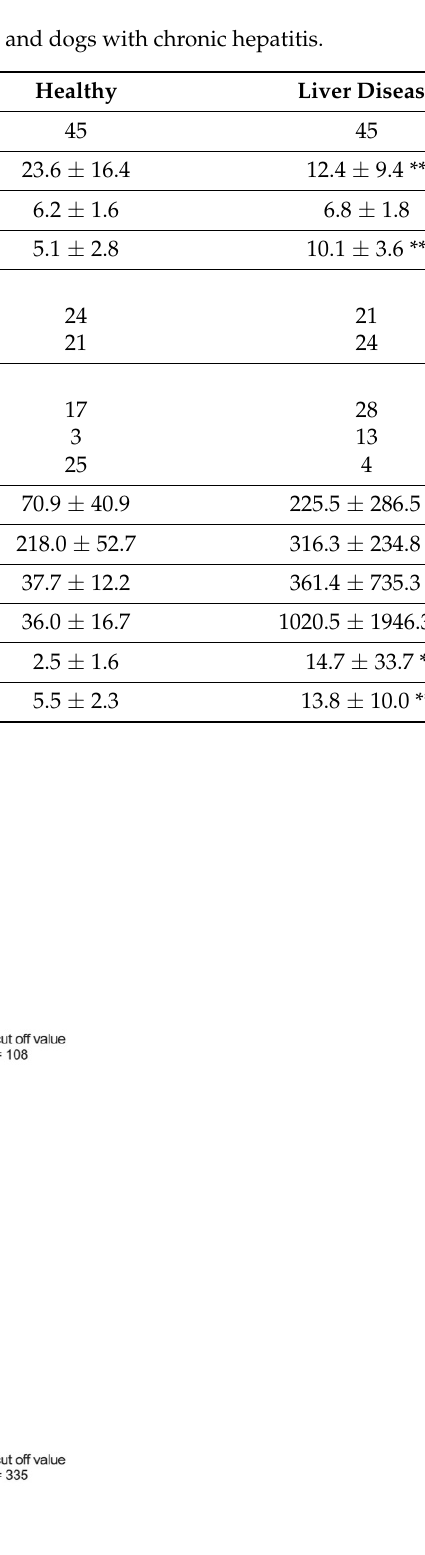
Figure 1. Scatterplots of serum triglyceride and cholesterol levels of healthy dogs and dogs with chronic hepatitis. Dots represent values of triglyceride levels ( A ) and cholesterol levels ( B ) for individual dogs, and lines represent mean ± SD. ** p < 0.01 vs. healthy.